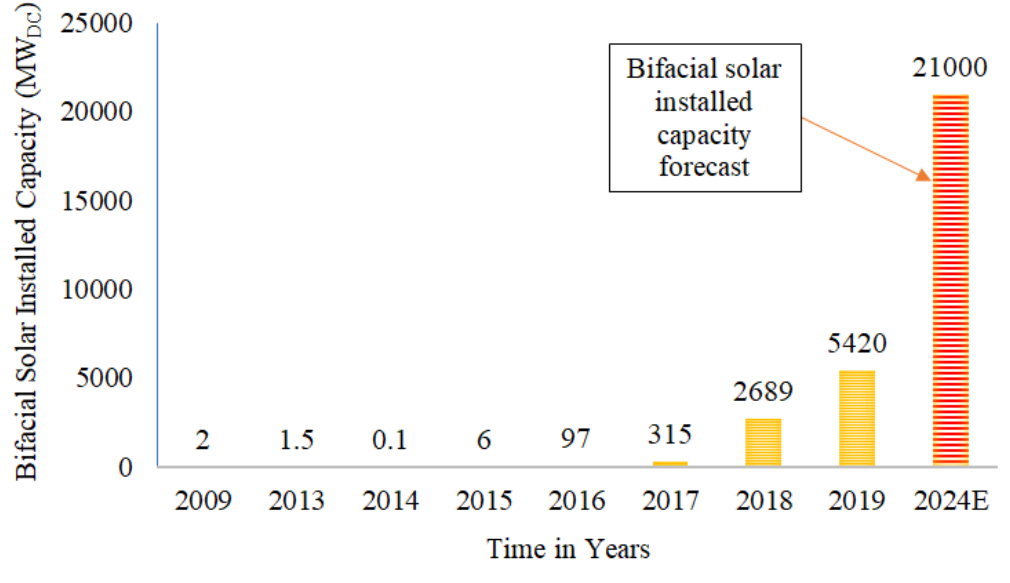
Figure 1. Global annual installed bifacial solar capacity. The top five countries with the highest bifacial solar installed capacity are shown in Figure 2. China leads with 6282 MW, exceeding the rest of the world combined [3]. Taiwan, Mexico, and Oman have approximately 100 MW of bifacial solar capacity installed. In bifacial projects in European countries approximately 10 – 35 MW are installed.